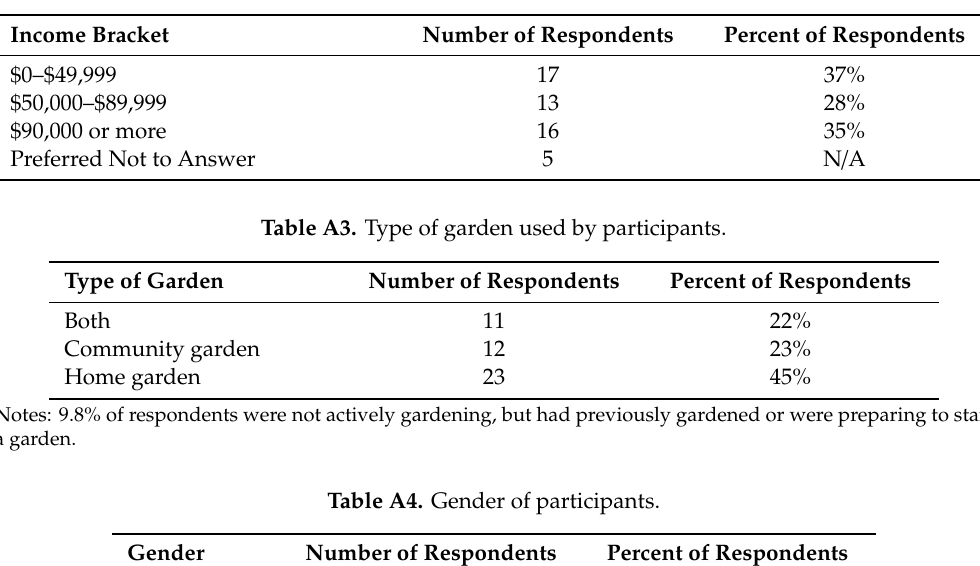
Table A2. Household income of participants.